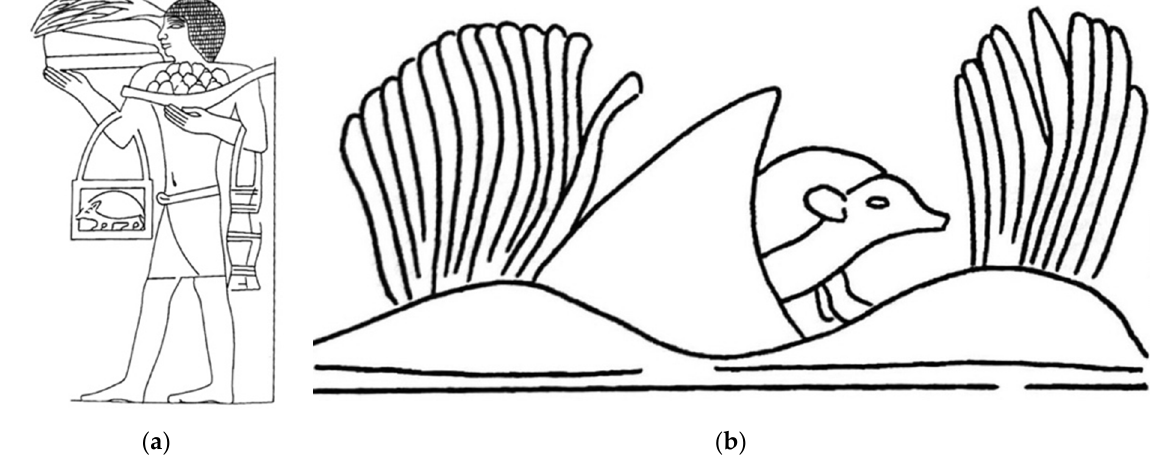
Figure 1. ( a ) Detail of offering bearer carrying piled offerings, with a live hedgehog in a cage held in his right arm. East thickness (bottom register) in doorway A3–A4 of Mereruka’s chapel, Saqqara. Adapted from line-drawing in Kanawati et al. (2010, pl. 75c). ( b ) Detail of hedgehog emerging from a burrow in a desert hunting scene. West wall of A3 in Mereruka’s chapel, Saqqara. Adapted from line drawing in Kanawati et al. (2010, pl. 73b).